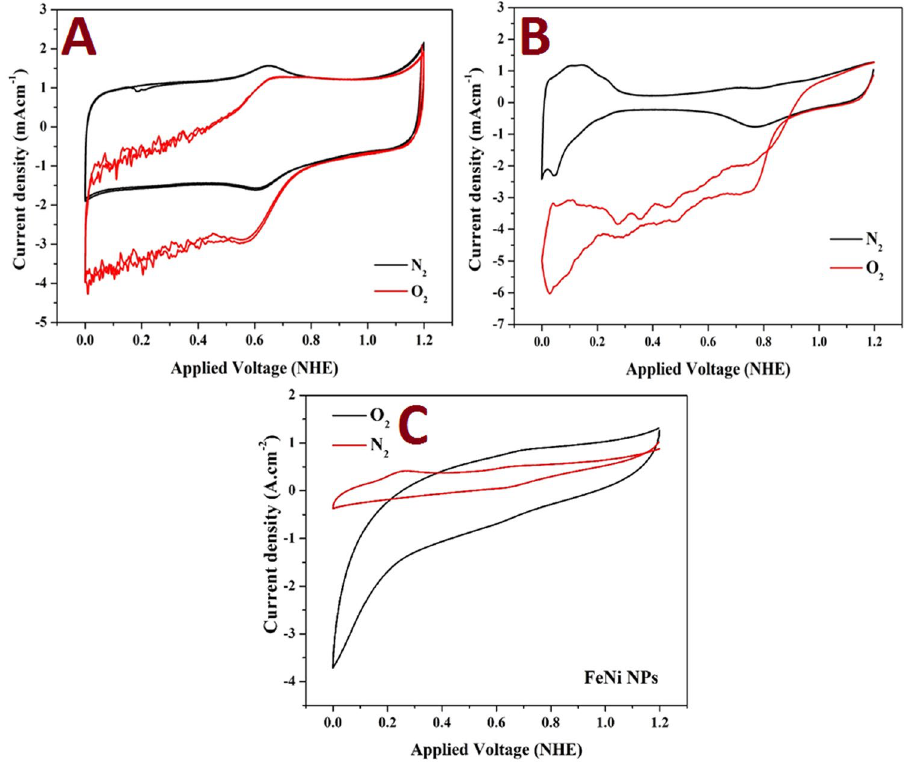
Figure 2. ORR activity at 5 mV.s − 1 in 0.5 M H 2 SO 4 for the ( A ) introduced FeNi-decorated and N-doped graphene, ( B ) Pt/C (20 wt%), and ( C ) FeNi